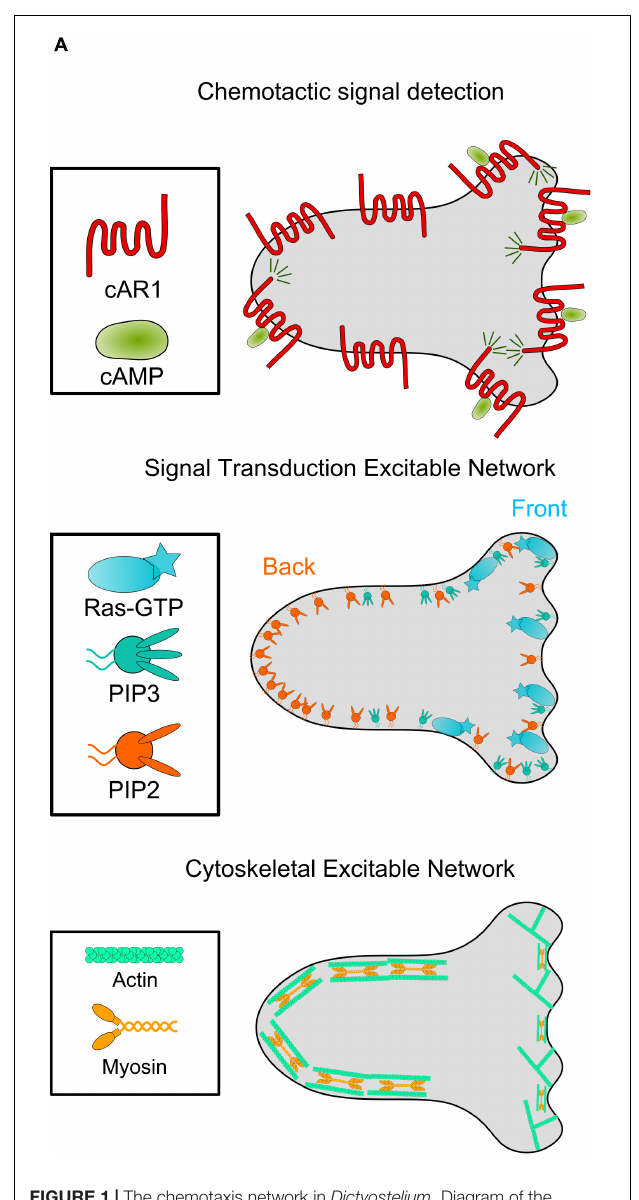
FIGURE 1 | The chemotaxis network in Dictyostelium . Diagram of the connected networks controlling Dictyostelium cyclic AMP (cAMP) chemotaxis. Top: the uniformly distributed G-Protein Coupled Receptor cAR1 binds to cAMP, leading to motion up the concentration gradient. Middle: cAMP-cAR1 interactions locally increase concentration of activated Ras and membrane lipid PI(3,4,5)P3 (PIP3), among other molecules. These molecules form the cell “front” and are mutually exclusive with localization of cell “back” molecules like PI(4,5)P2 (PIP2). Together, these signaling molecules form the Signal Transduction Excitable Network. Bottom: Active Ras enrichment leads to an increase in actin polymerization at the cell front. Meanwhile, cell back signaling molecules activate the contraction of an actomyosin network. This Cytoskeletal Excitable Network powers